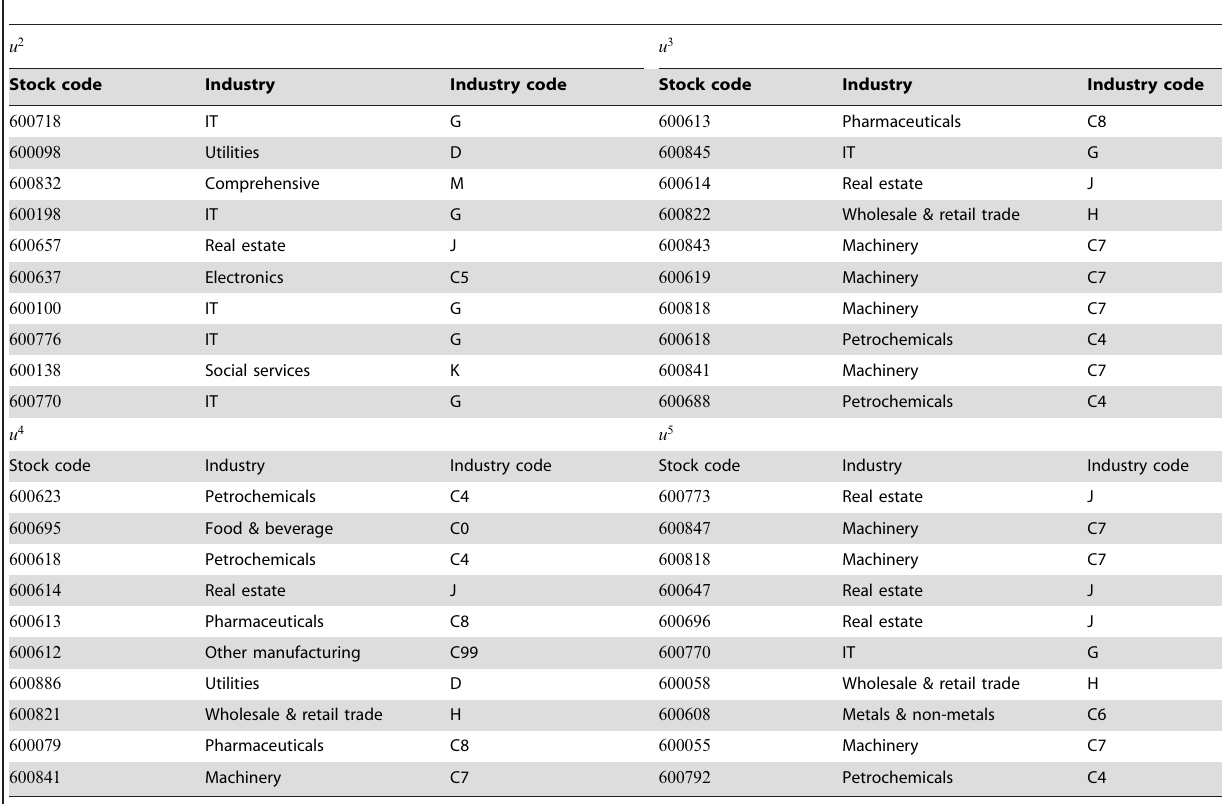
Table 2. Largest ten components of deviating eigenvectors in period from 06/09/2000 to